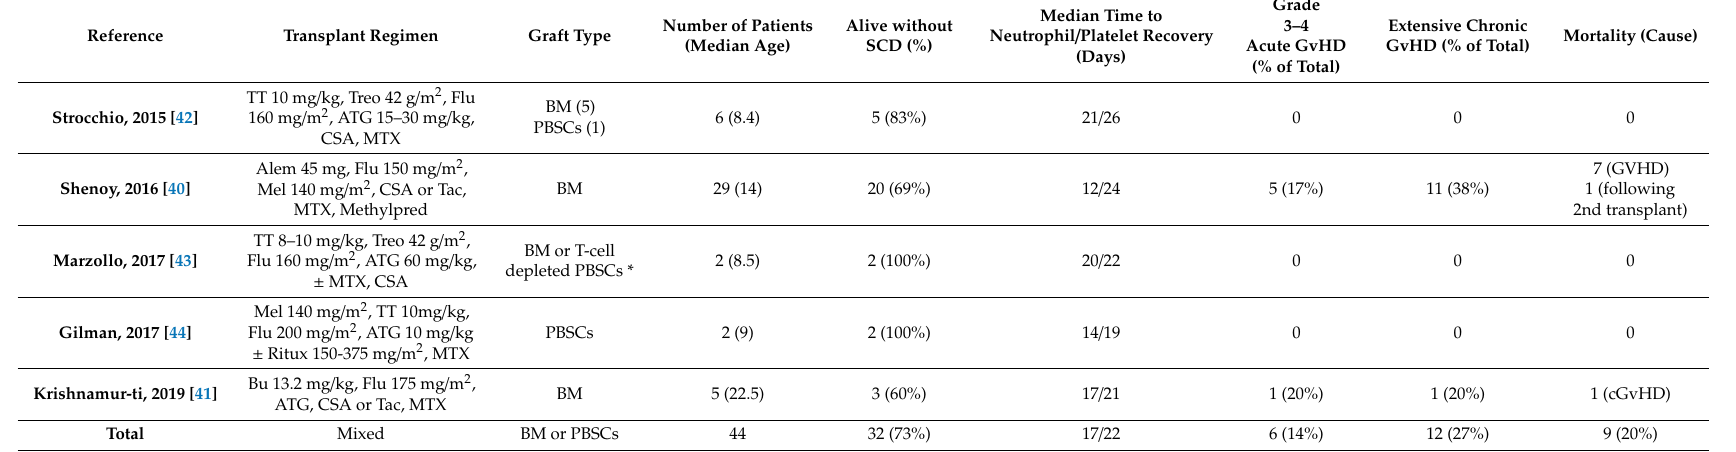
Table 3. Matched unrelated donor transplants for